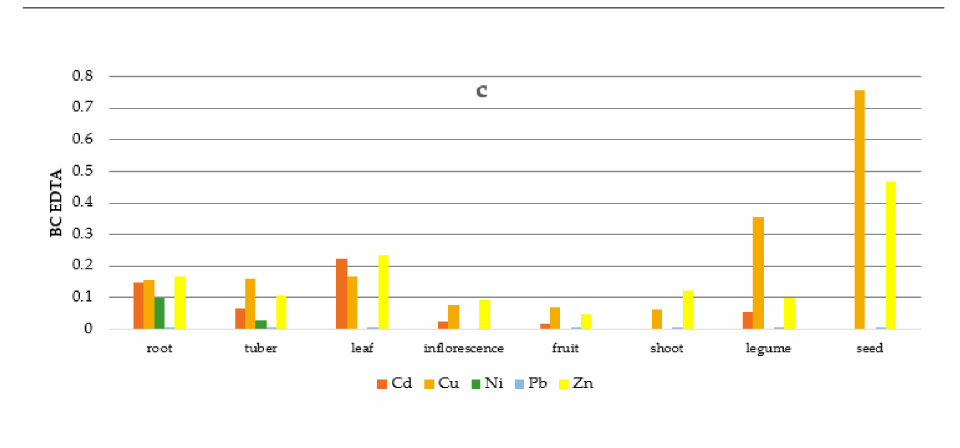
Figure 2. Soil-to-plant transfer indices for the analyzed groups of vegetables: ( a ) BA total —bioaccumulation coefficient, total PHE content, ( b ) BC F1 —bioconcentration coefficient, PHE content of the F1 fraction